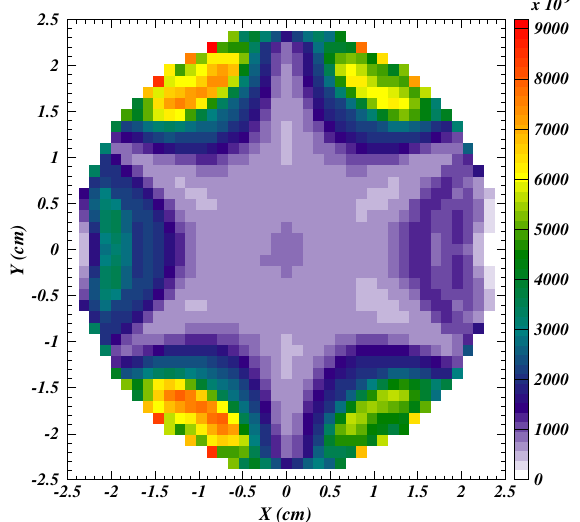
FIG. 12. Simulated EC density profile averaged over the 2 . 2 μ s simulation time in an ILC DR sextupole magnet.